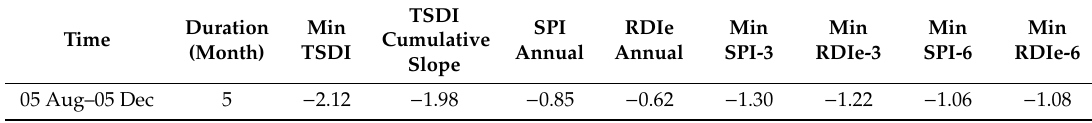
Table 8. The time and severity of hyper-arid droughts in the area under